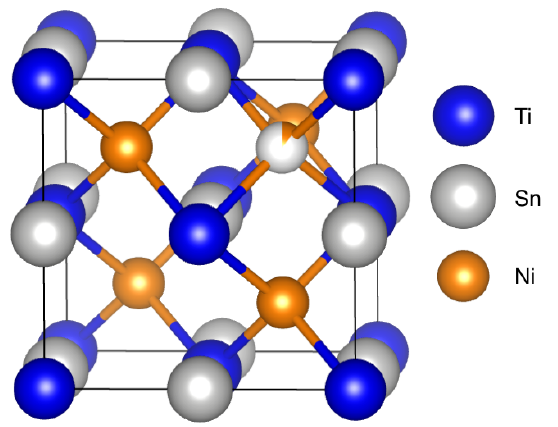
Figure 1. Crystal structure of half-Heusler TiNiSn in the F 43 m space group. Excess Ni occupies vacant tetrahedral sites, as shown by the partially-occupied Ni interstitial. All four of the vacant tetrahedral sites are filled in the full-Heusler, in the space group Fm 3 m